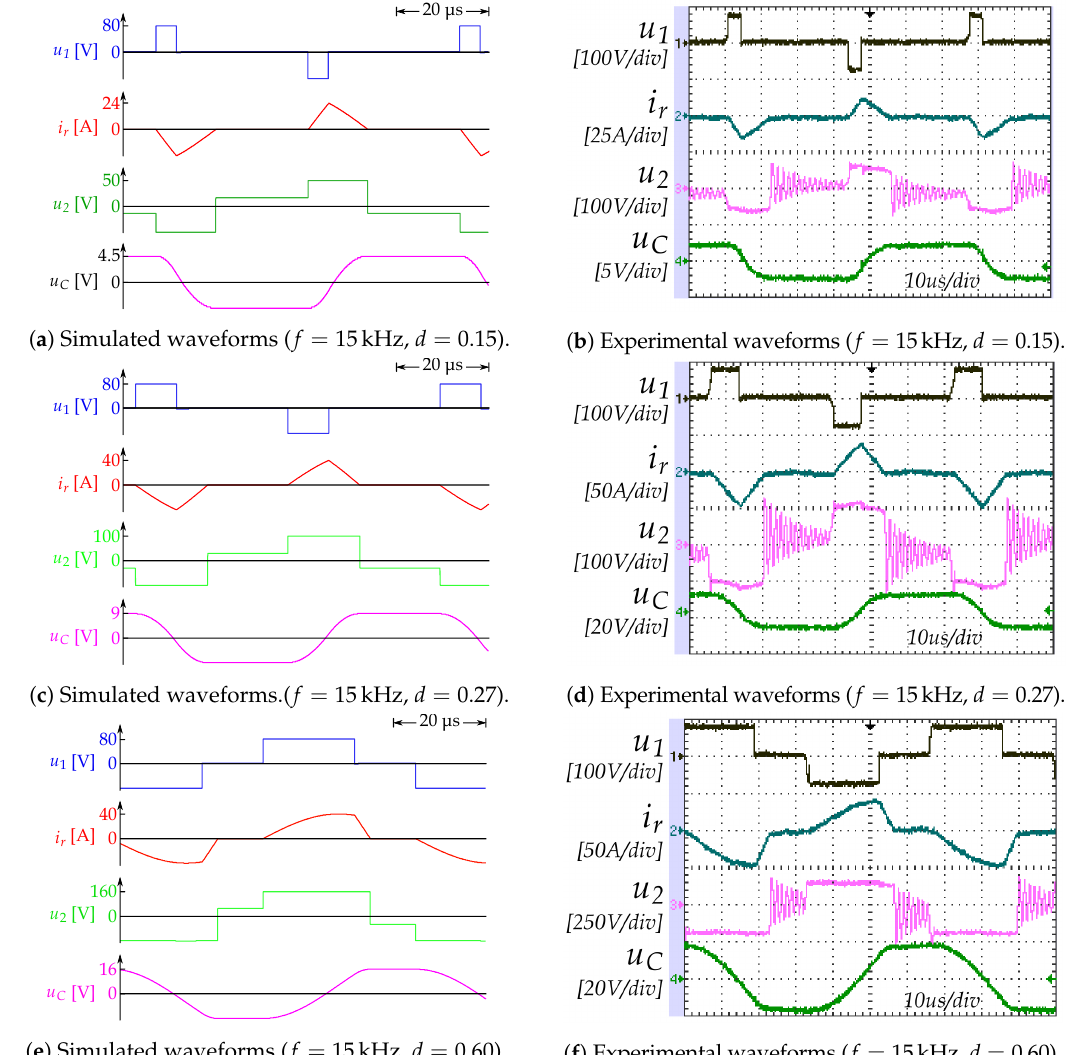
( f ) Experimental waveforms ( f = 15kHz, d = 0.60). Figure 13. Proposed Converter with Fixed Frequency Modulation (FFM) waveforms. ( a , b ) U 1 = 80V, U 2 = 50V, I OUT = 2.5A. ( c , d ) U 1 = 80V, U 2 = 100V, I OUT = 5A. ( e , f ) U 1 = 80V, U 2 = 160V, I OUT =